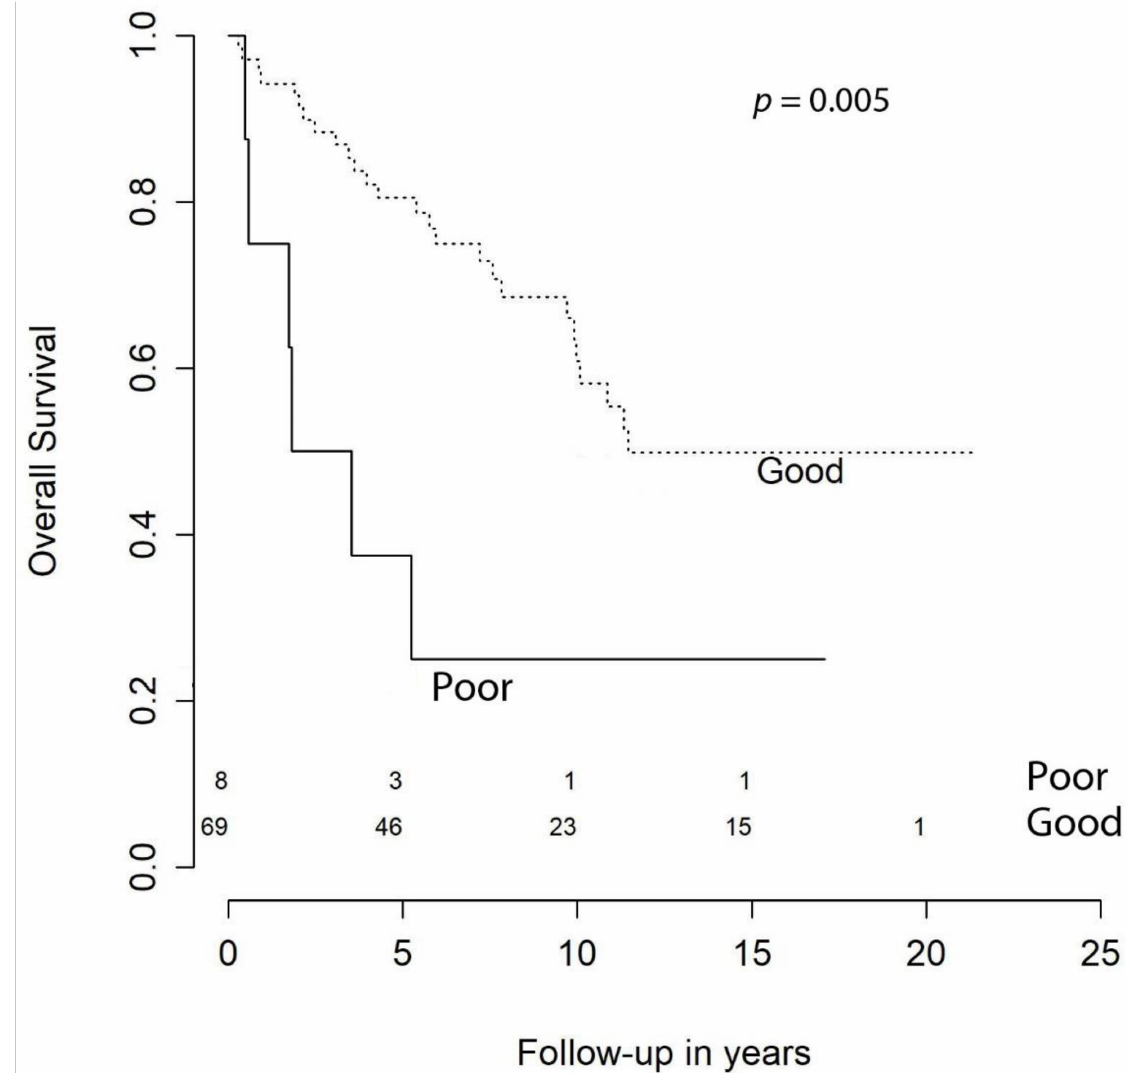
Figure 3. Overall survival by preoperative